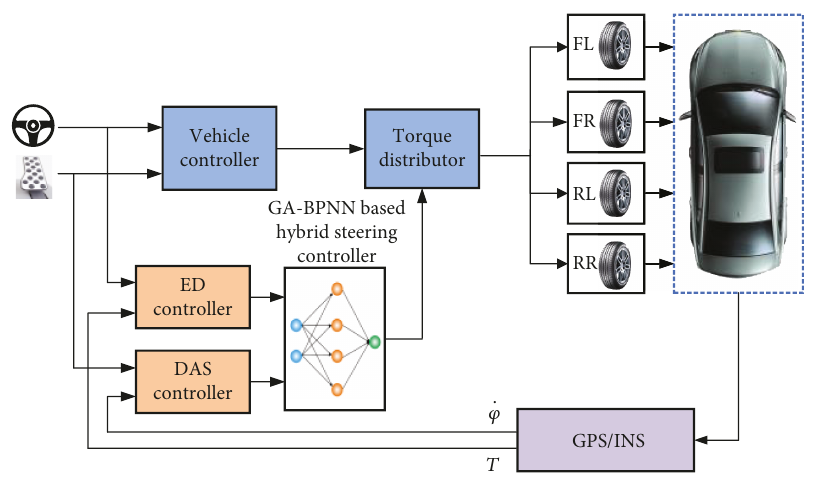
Figure 5: The principle of the coordinate control